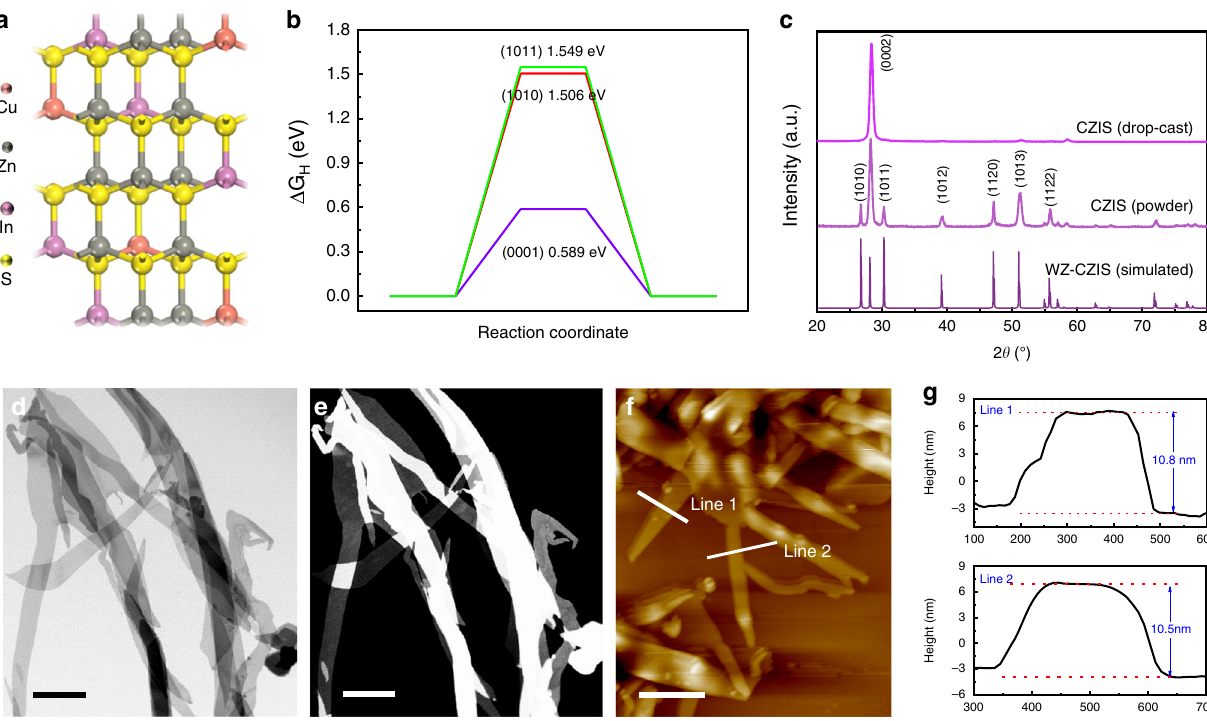
Fig. 1 DFT calculation and two-dimensional morphology of CZIS nanobelts. a The simulated crystal structure model. b Reaction Gibbs energy diagram for H 2 evolution of (0001), (1010), and (1011) crystal facets, respectively. c XRD patterns of the obtained CZIS nanobelts. The simulated wurtzite XRD pattern of CZIS is shown below for reference. d , e TEM and HAADF-STEM images of CZIS nanobelts. f , g AFM image and corresponding height images of the obtained wurtzite CZIS nanobelts. Scale bars are 500 nm for d and e , 1 μ m for f ,